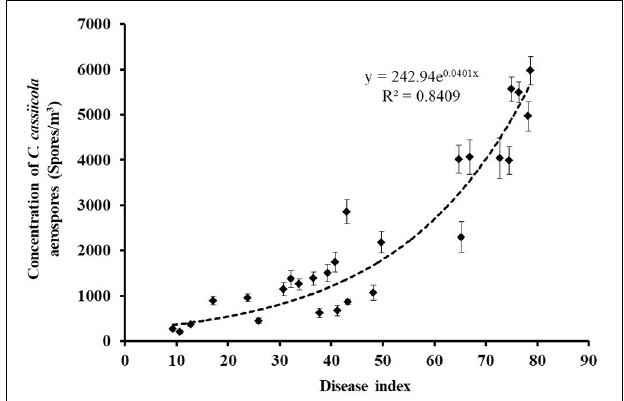
FIGURE 4 | The concentrations of Corynespora cassiicola aerospores were plotted against the corresponding disease index values from naturally infested greenhouses. As the disease incidence increased gradually from 9.26 to 78.70, the concentration of C. cassiicola aerospores in greenhouses increased exponentially from 198 to 5,969 spores/m 3 . Error bars represent standard deviation (SD) from three